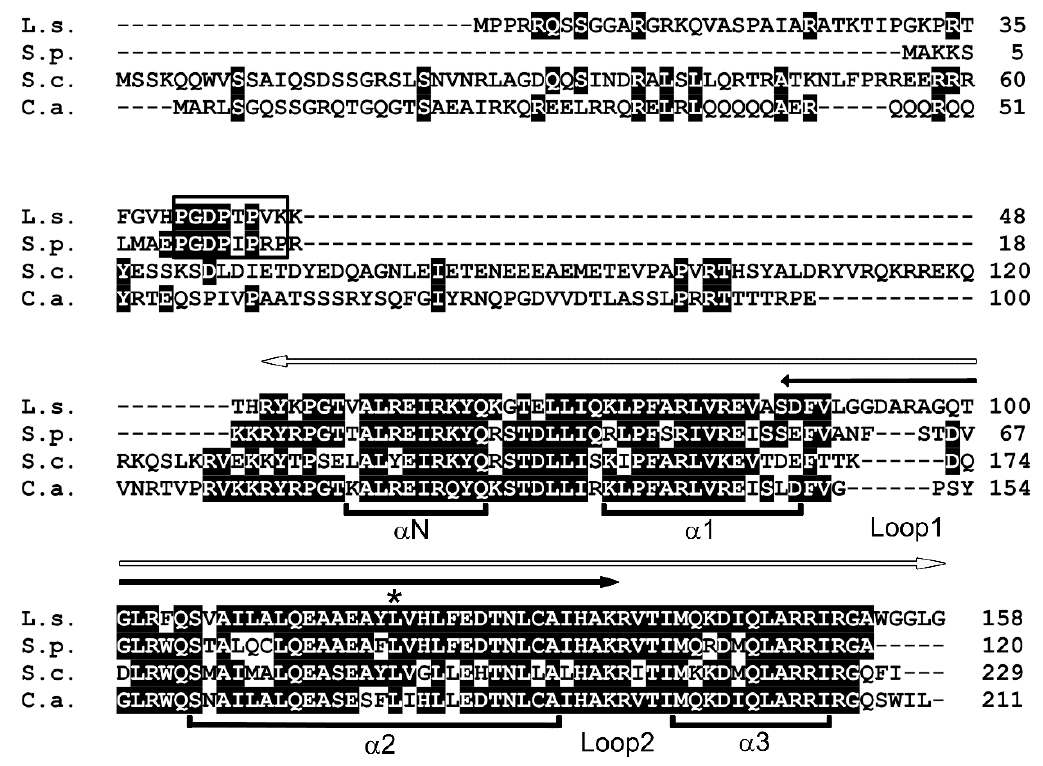
Figure 1. Amino acid sequence alignment of CENP-A proteins. L. starkeyi (L.s.), S. pombe (S.p.), S. cerevisiae (S.c.), and C. albicans (C.a.). Black boxes indicate identical amino acid residues. White arrow, conserved histone fold domain. Black arrow, centromere targeting domain. Open box, genomic stability-regulating site within CENP-A N-terminus (GRANT) motif. Asterisk, the position of the cnp1-1 mutation. The α -helices are indicated ( α N, α 1, α 2, and α 3).